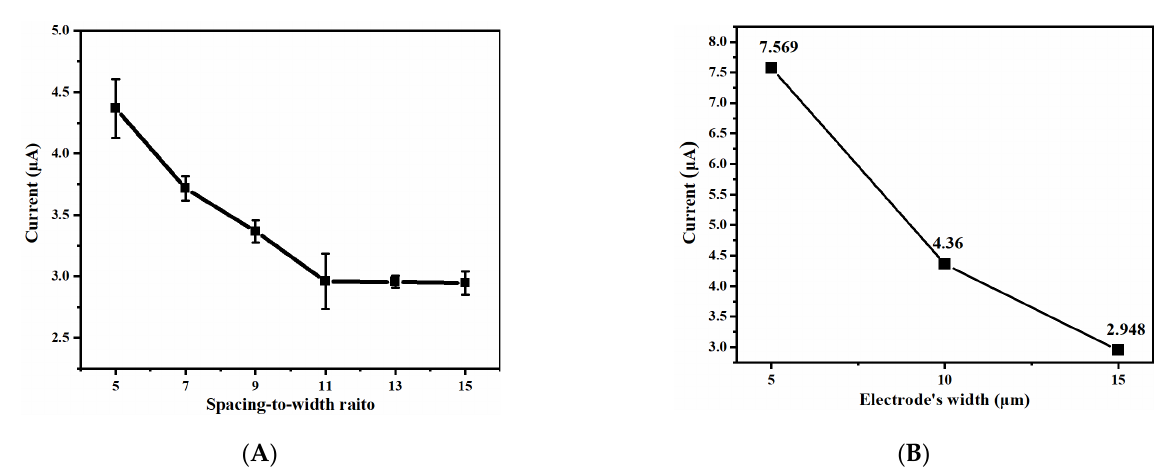
Figure 8. Cyclic voltammogram and the relationship between the oxidation peak current and the square root of scanning rate (inset) of UIAE with different spacing-to-width ratios: ( A ) 15; ( B ) 13; ( C ) 11; ( D ) 9; ( E ) 7; ( F ) 5. ( C ) 11; ( D ) 9; ( E ) 7; ( F ) 5.